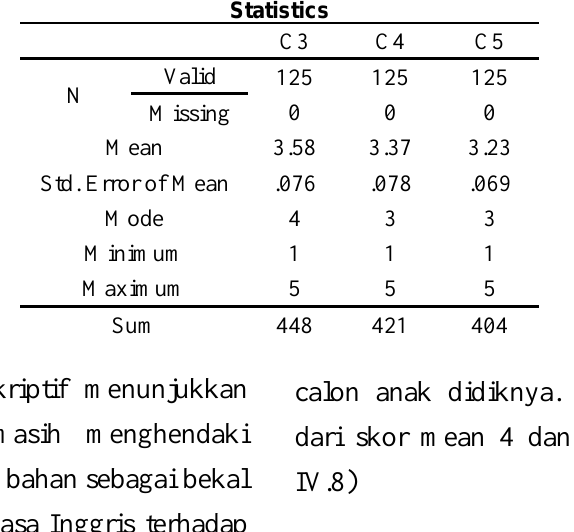
Tabel IV. 7.: Variabel